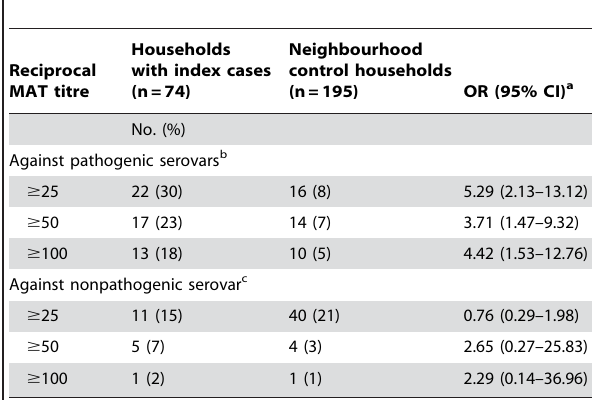
Table 3. Prevalence of anti- Leptospira antibodies among age groups residing in households with an index cases of severe leptospirosis and neighbourhood control